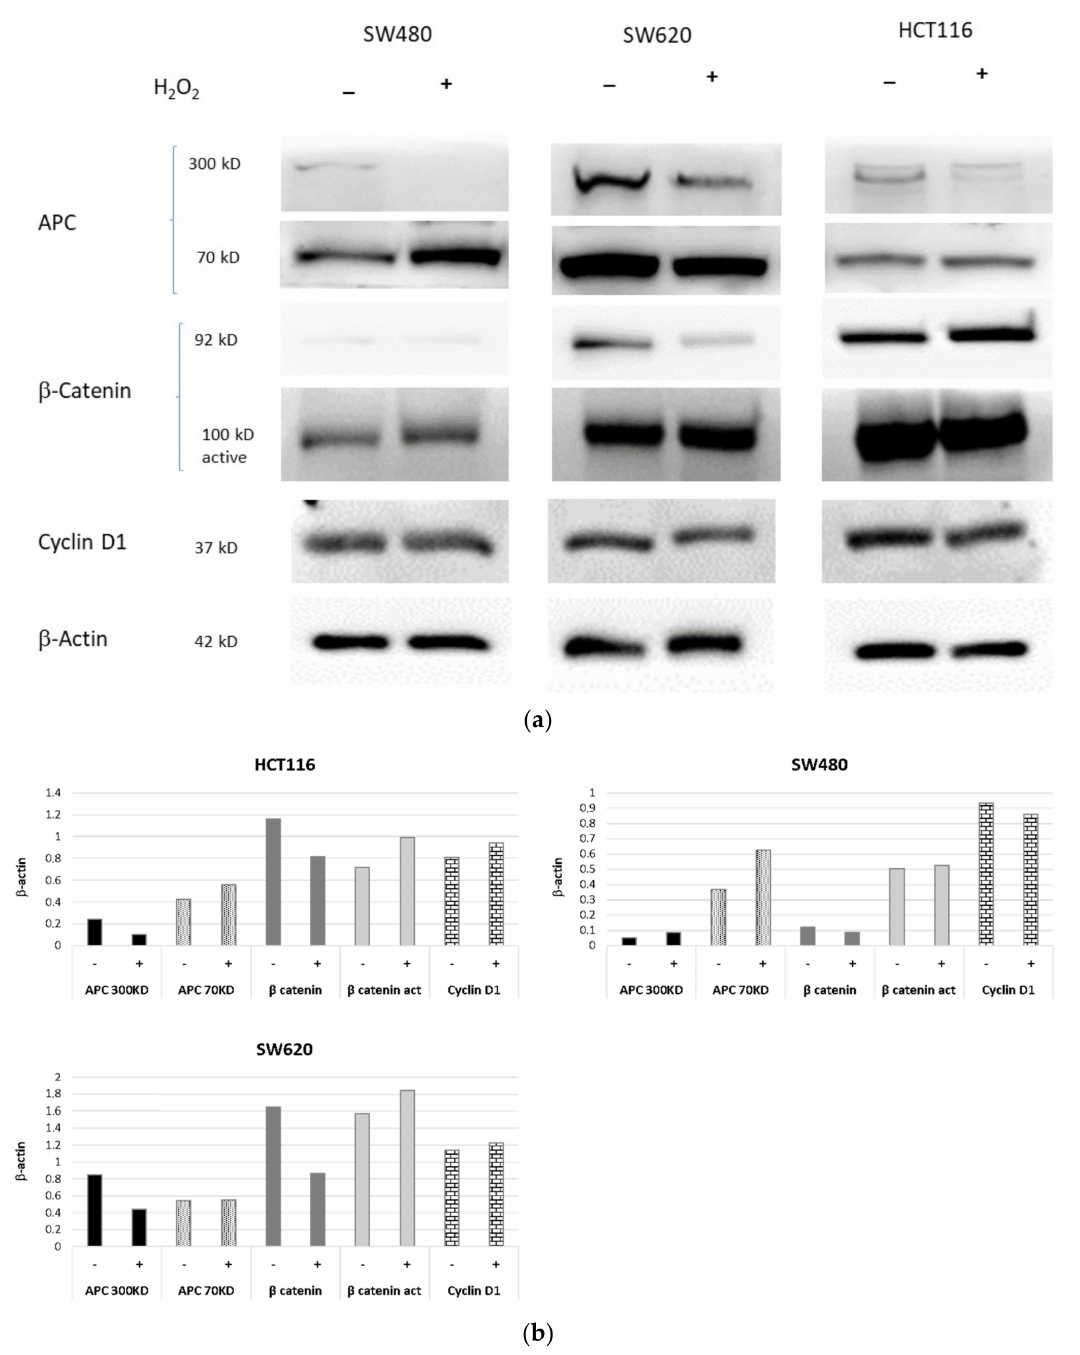
Figure 6. Protein expression of APC, β -Catenin and Cyclin D1 in HCT116 vs. SW480 vs. SW620 cells. The cells were starved overnight and treated with H 2 O 2 [2 mM]. ( a ) Protein expression detected by Western blotting analysis are representative of three independent experiments. ( b ) The average expression levels of panel were determined by densitometric analysis and calculated in relation to the β -Actin level. kD: Kilodalton as protein molecular weight